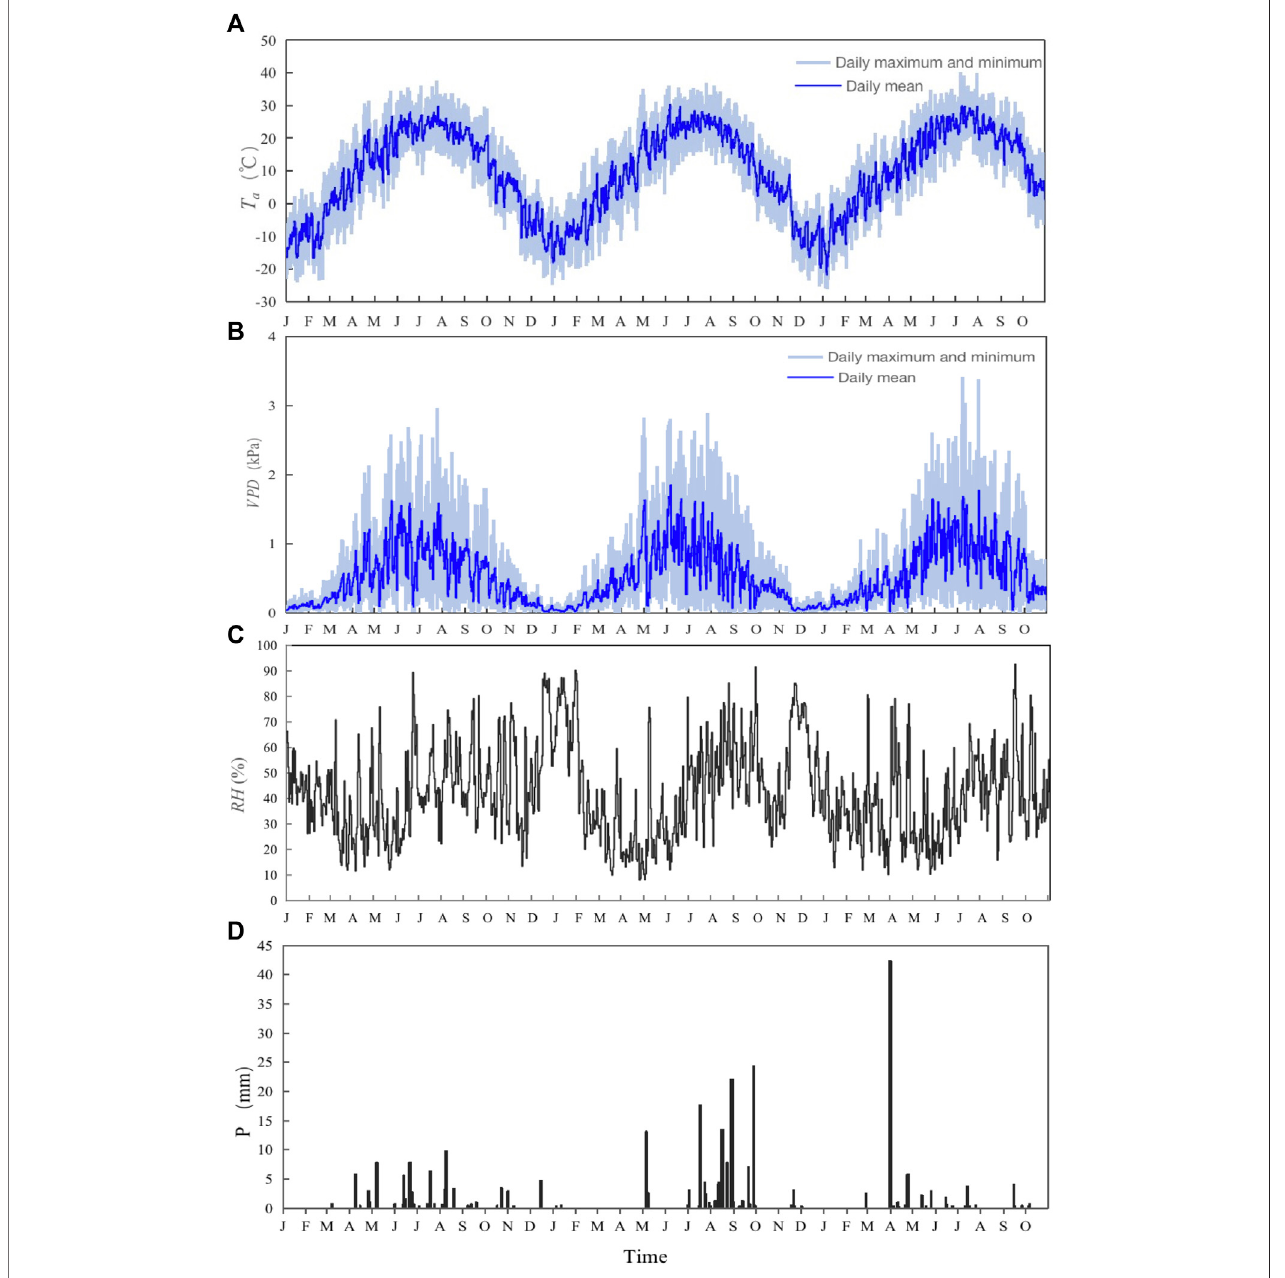
FIGURE 2 | Seasonal dynamics of (A) daily average relative air temperature ( T a ), (B) vapor pressure de fi cit ( VPD ), (C) humidity ( RH ) and (D) interannual distribution of total daily precipitation ( P ) in the study area.